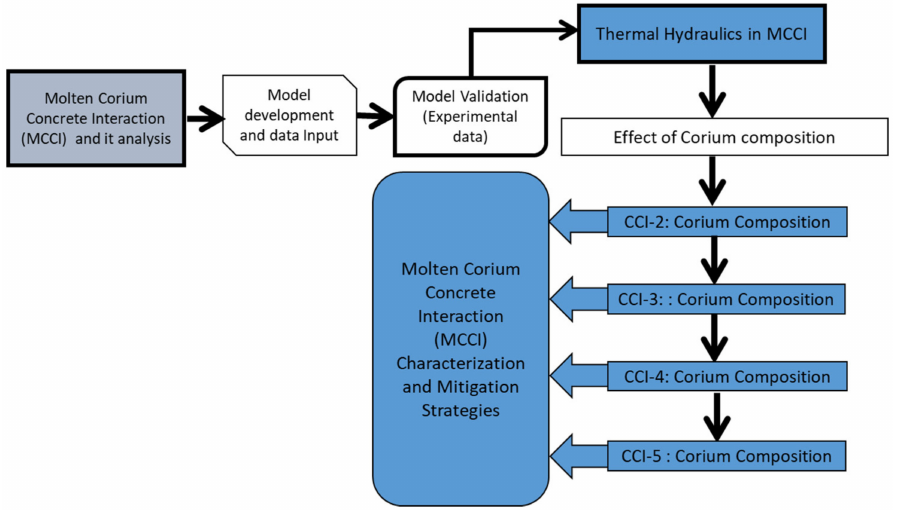
Figure 2. Flowchart to determine the effect of corium composition on MCCI